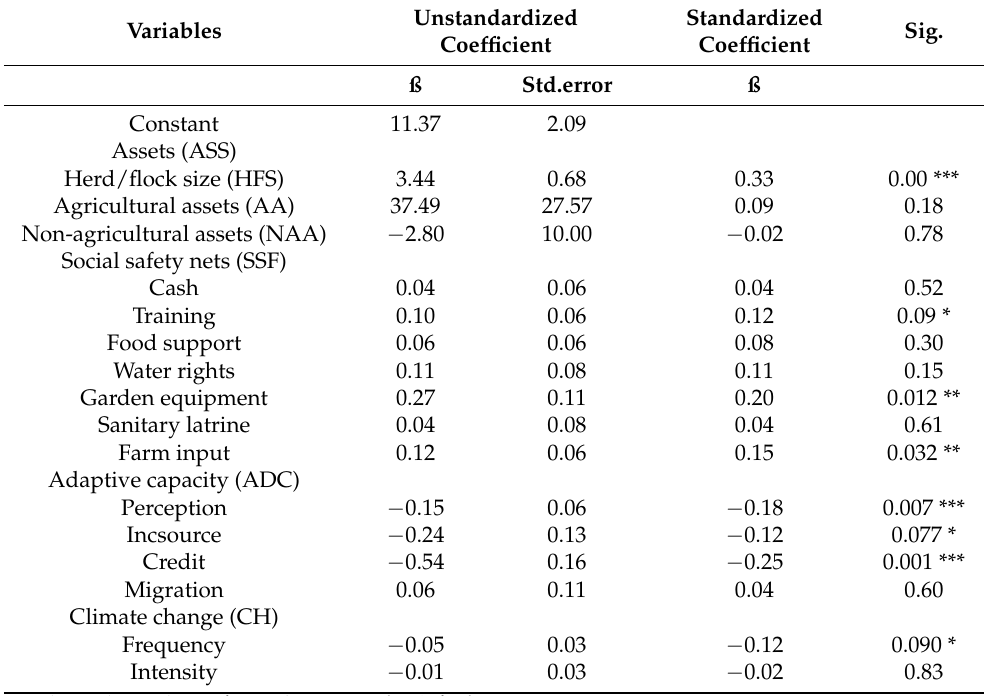
Table 6. Results of the structural equation